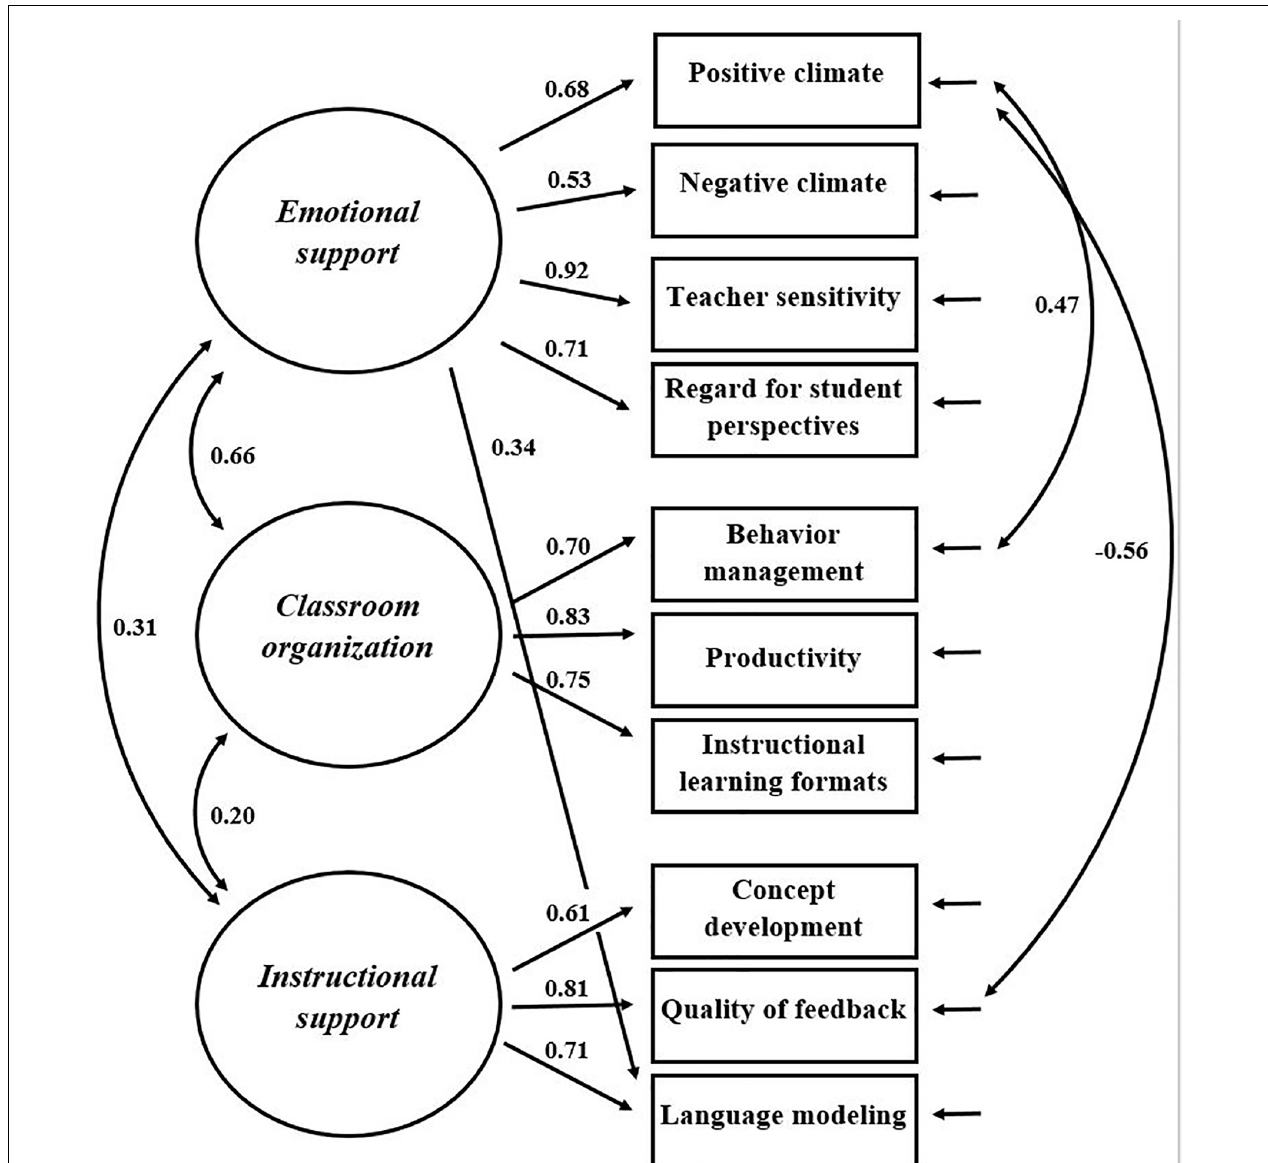
FIGURE 4 | Revised three-factor model (a cross-loading of language modeling on emotional support and correlated errors between positive climate and quality of feedback, as well as between positive climate and behavior management were specified) with standardized parameter